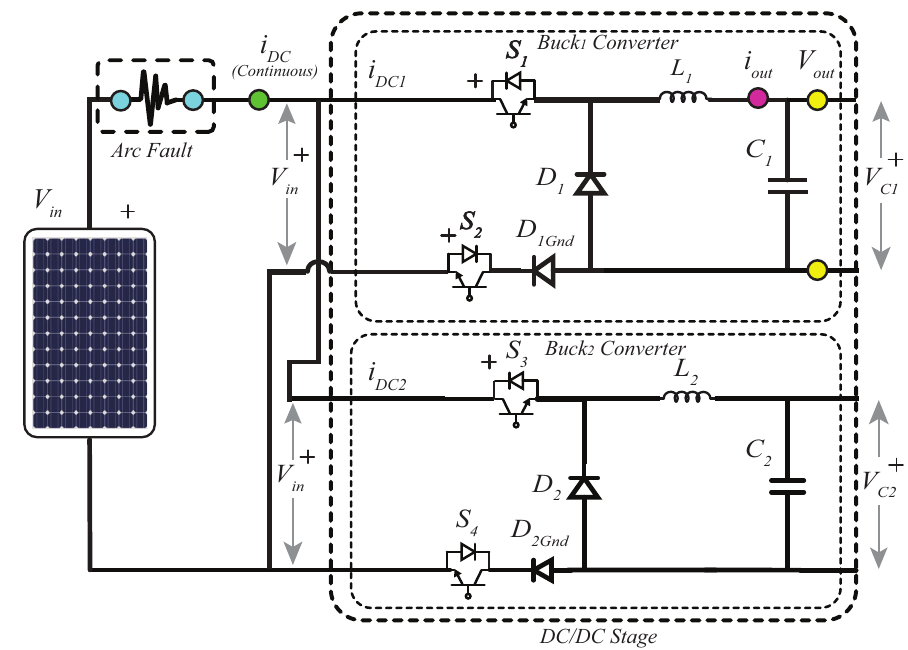
Figure 10. Highlighted DC/DC stage